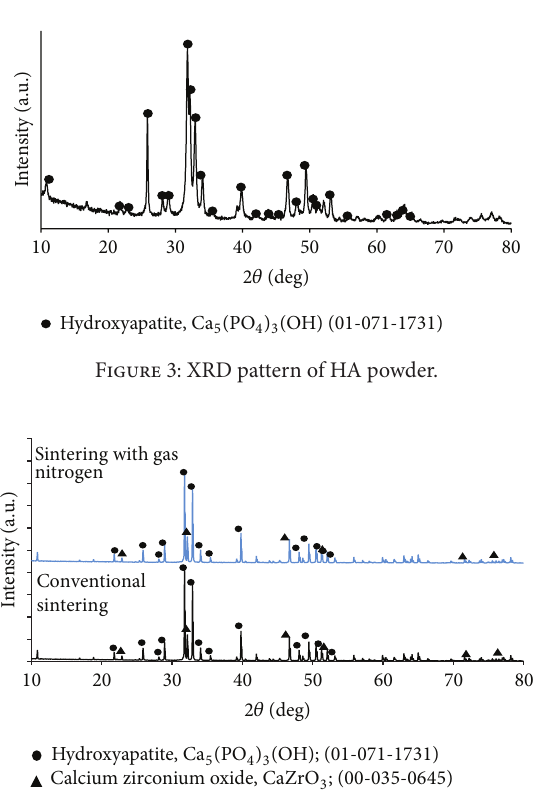
Figure 2: TEM micrograph of 3YSZ powder.